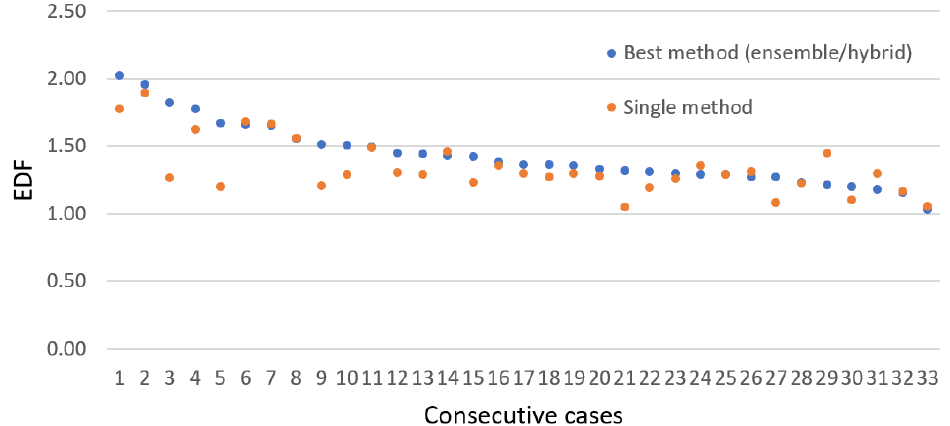
Figure 18. Pairs of EDF sorted in descending order by the level of quotients for the best method.